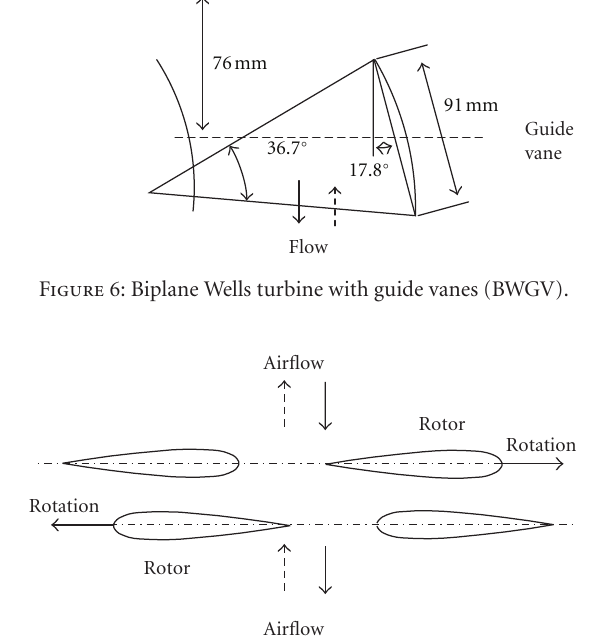
Figure 7: Contrarotating Wells